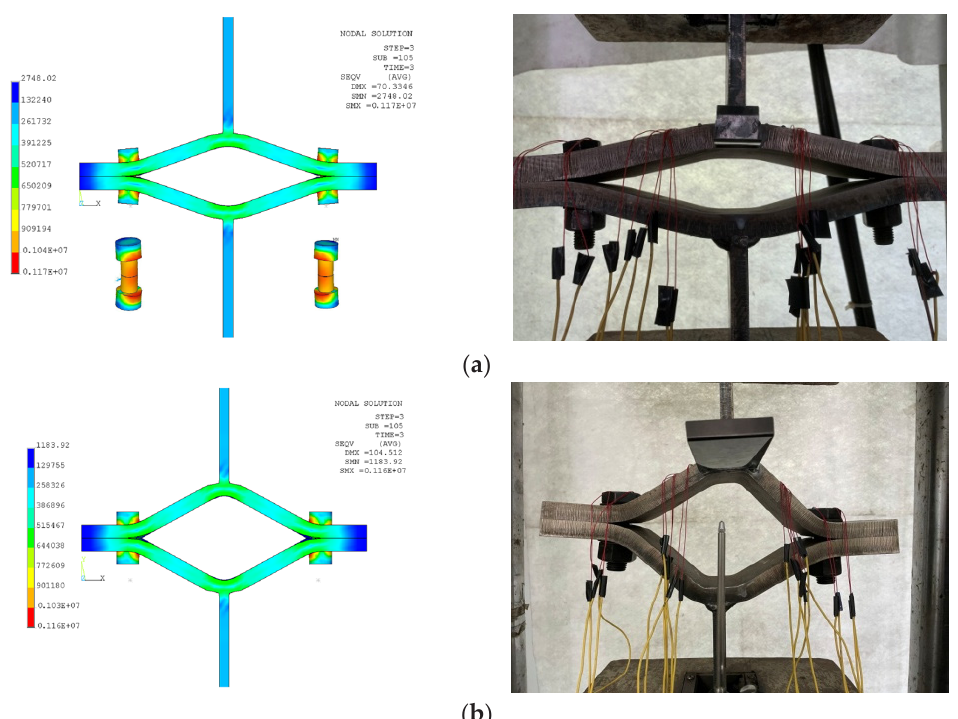
Figure 12. Comparison of specimens D16 and M20 simulation and test deformation. ( a ) Specimen D16, ( b ) Specimen